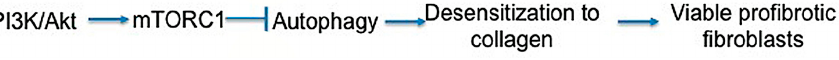
Figure 8. PI3K/AKT dependent autophagy regulation in IPF fibroblasts. The arrows indicates positive regulation while the symbol T indicates the inhibition of autophagy.